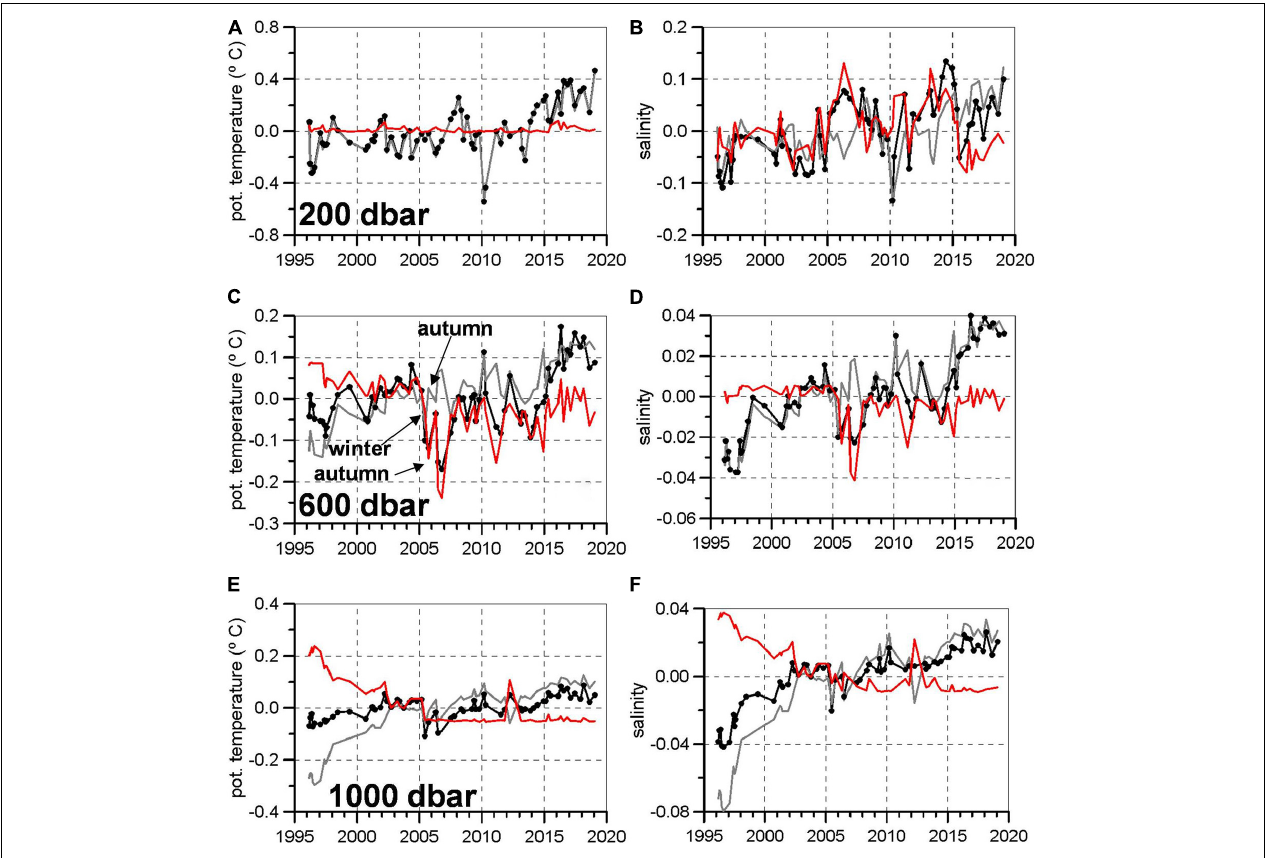
FIGURE 10 | Potential temperature (A,C,E) and salinity (B,D,F) variations from reference profiles (averaged for the complete time series) at three selected isobaric levels representative of different water masses: 200 dbar (WIW), 400 dbar (LIW), and 1000 dbar (DW). For each variable and isobaric level, the black line represents changes on isobaric levels, the gray line represents changes on isopycnals, the red line represents changes caused by isopycnal heaving, and black dots are the sum of isopycnal and heaving changes.